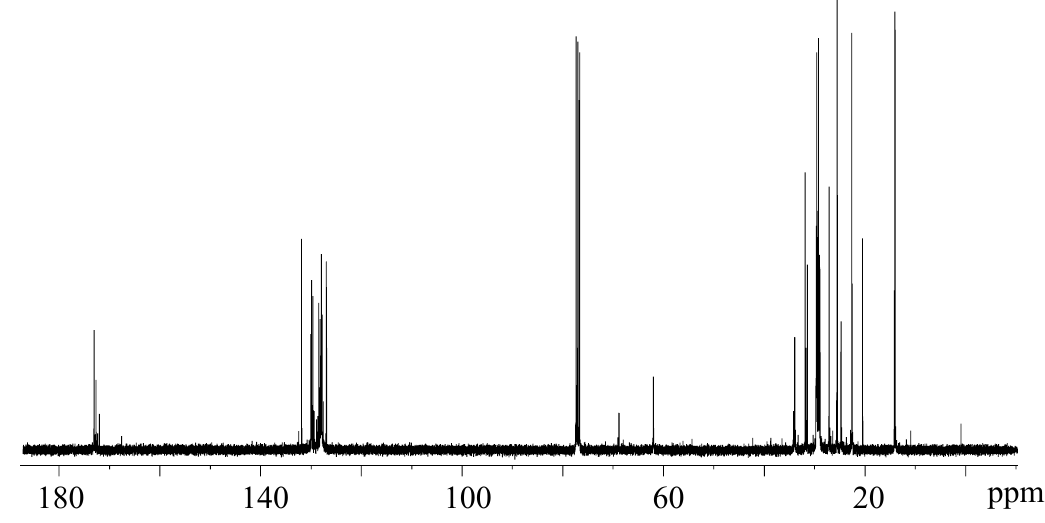
of Sparus aurata lipid fraction. 3